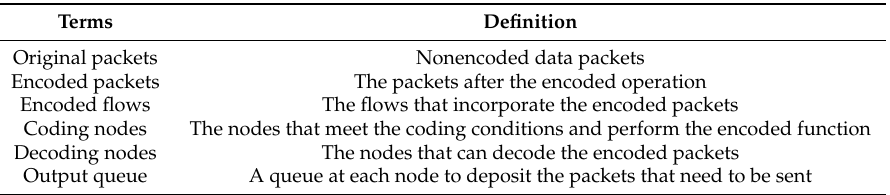
Table 2. Definition of